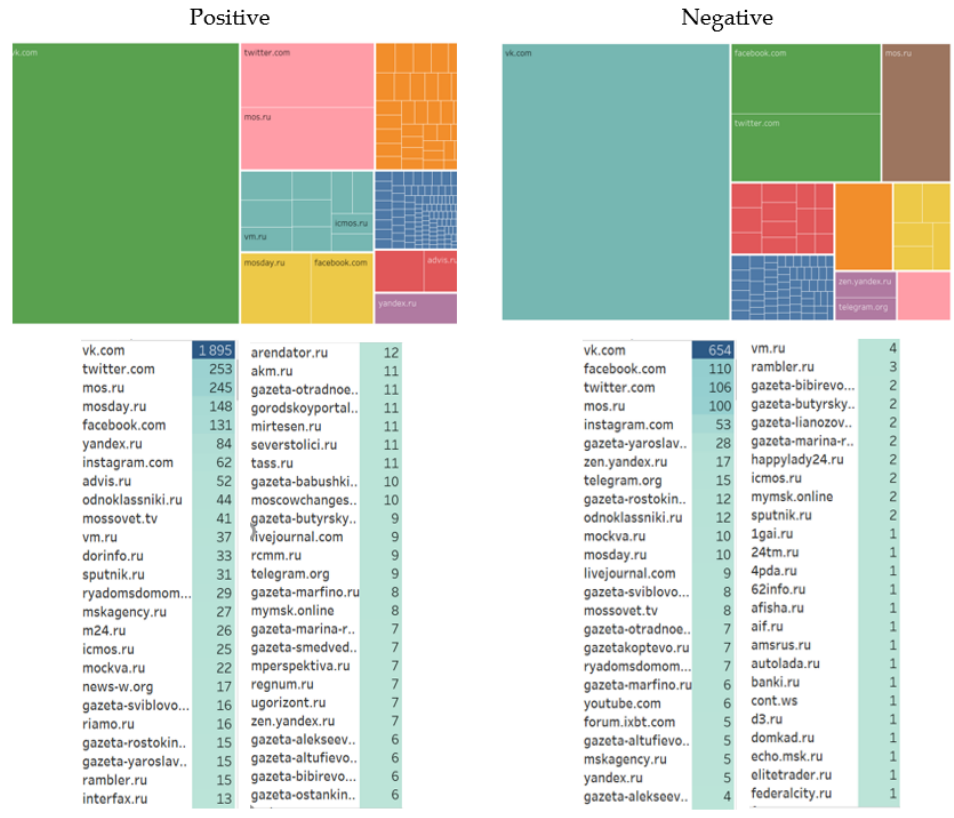
Figure 7. Distribution of negative and positive messages across digital platforms.